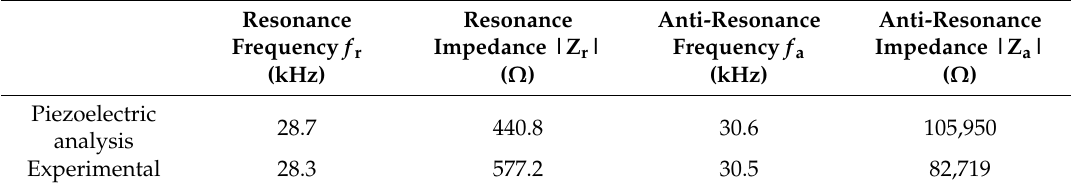
Table 2. Analytical and experimental values of the resonance frequency, resonance impedance, anti-resonance frequency, and anti-resonance impedance for the sensor